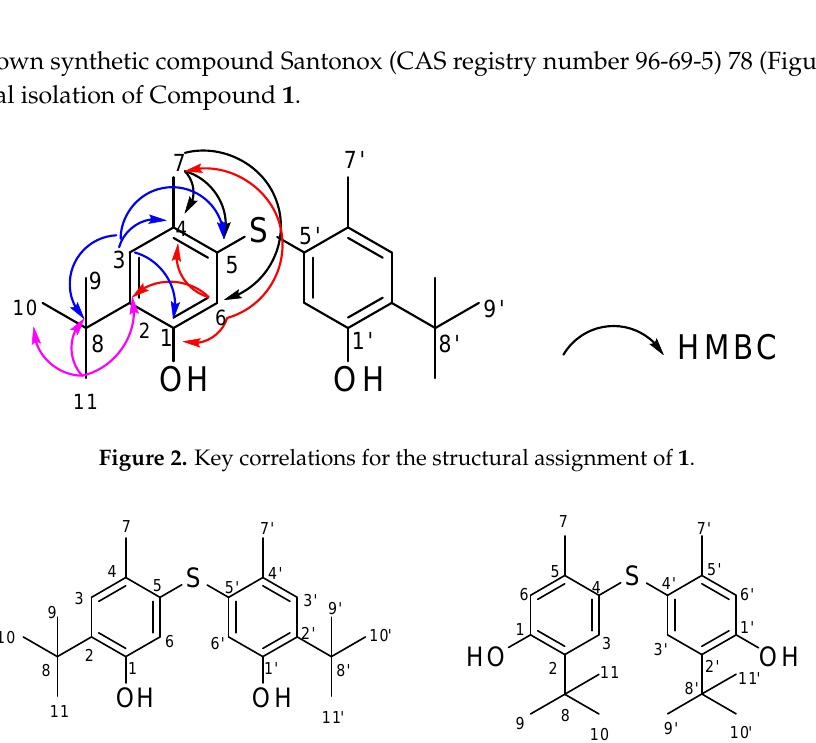
Figure 3. Structures of Compound 1 and Santonox.